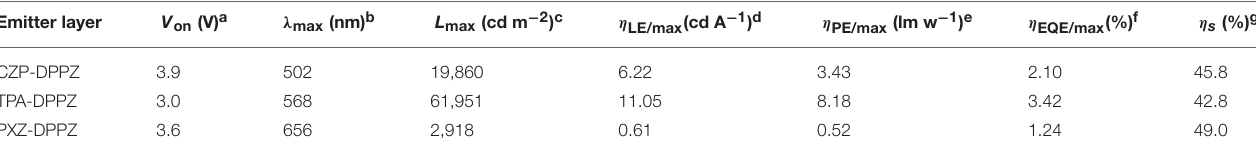
TABLE 2 | The electroluminescence device performances of emissive materials. Emitter layer